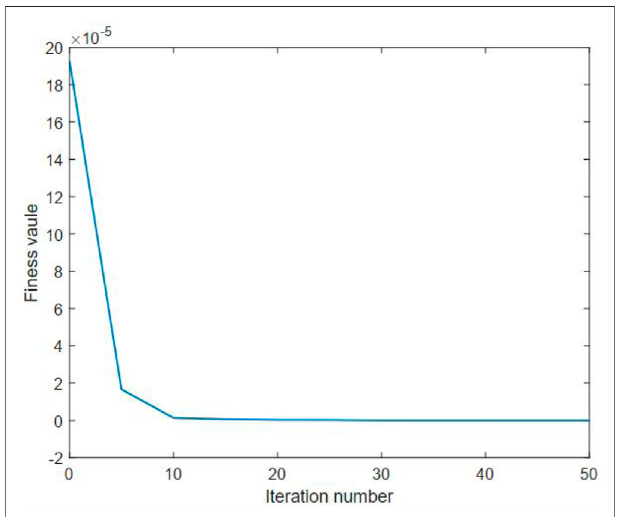
FIGURE 2 | Average fi tness curve of the upper level for the benchmark test